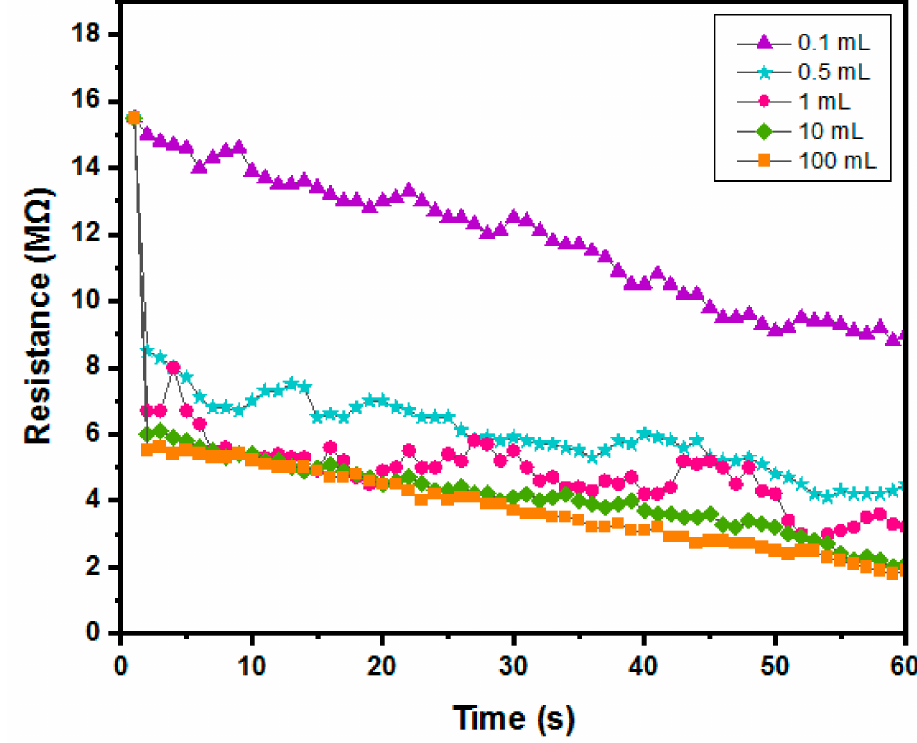
Figure 10. Graph of the resistance change of the humidity sensor against different amounts of